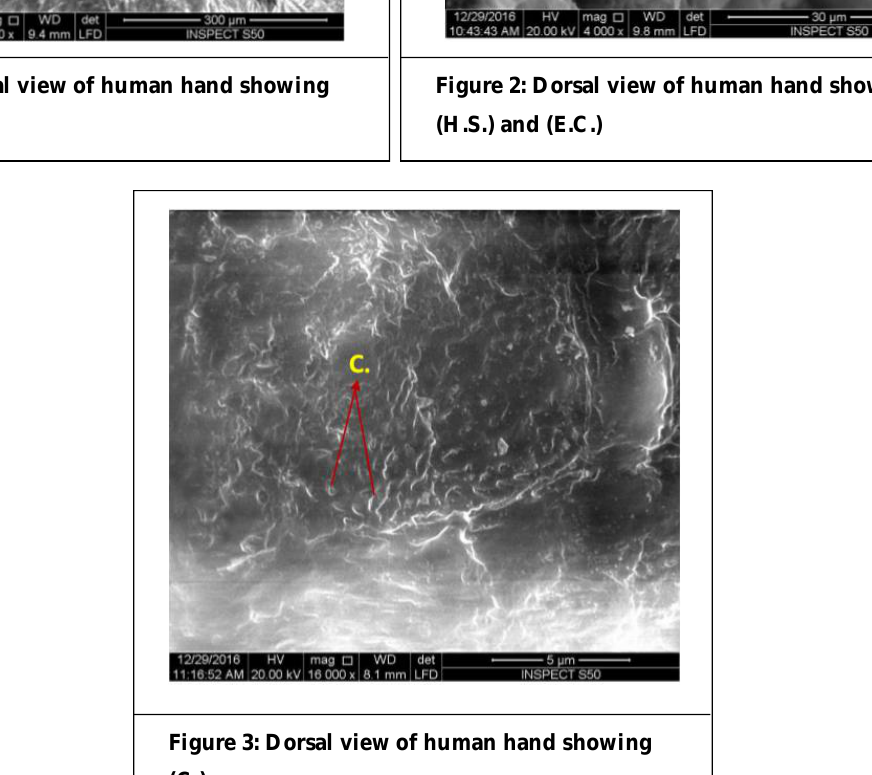
Figure 3: Dorsal view of human hand showing (C.)